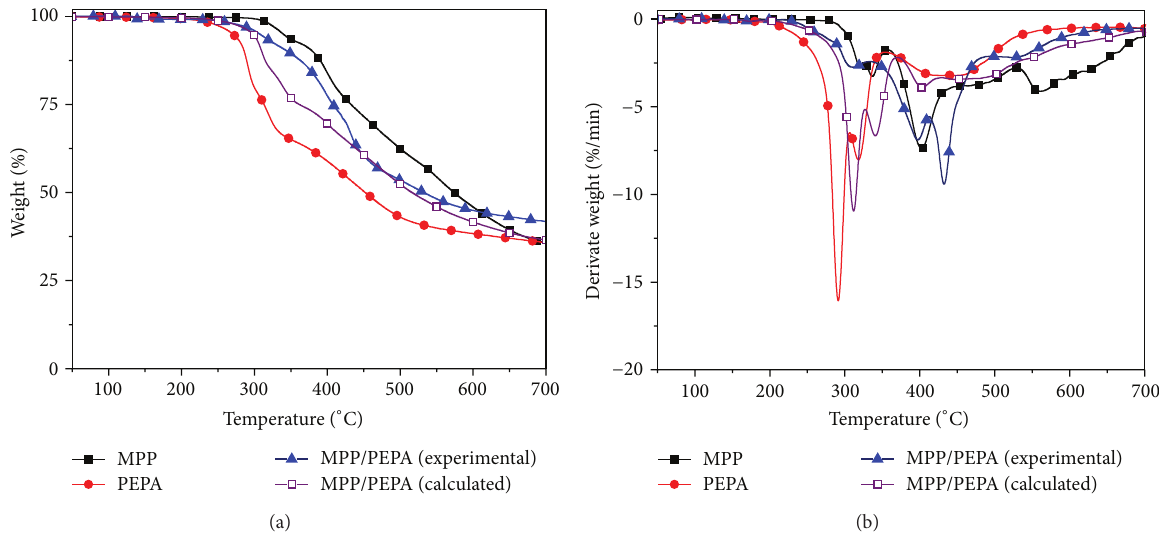
Figure 4: (a) TGA and (b) DTG curves of MPP, PEPA, and MPP/PEPA under air atmosphere. Note: the mass ratio of MPP to PEPA was 1: